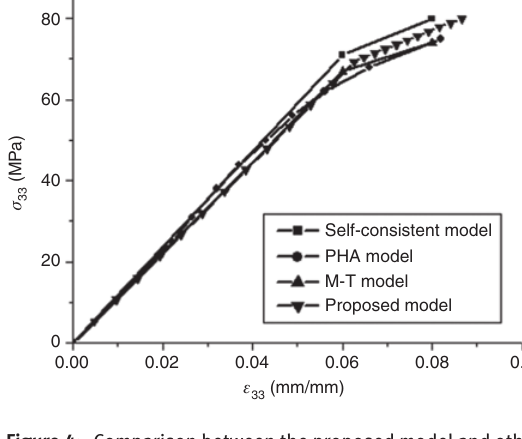
Figure 4: Comparison between the proposed model and other numerical